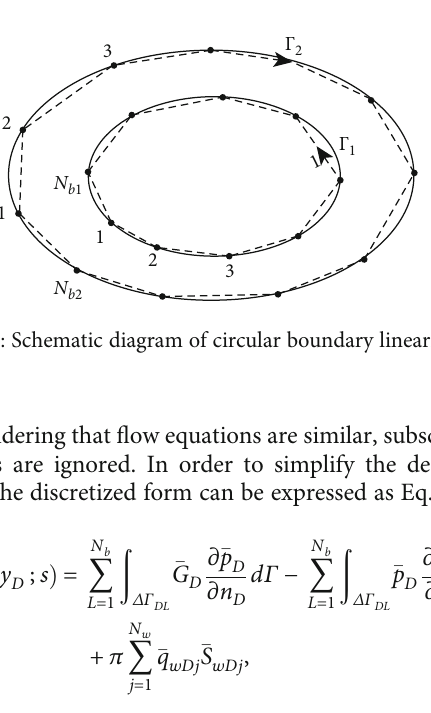
Figure 3: Field test data and history matching curves by conventional model and our new bizone